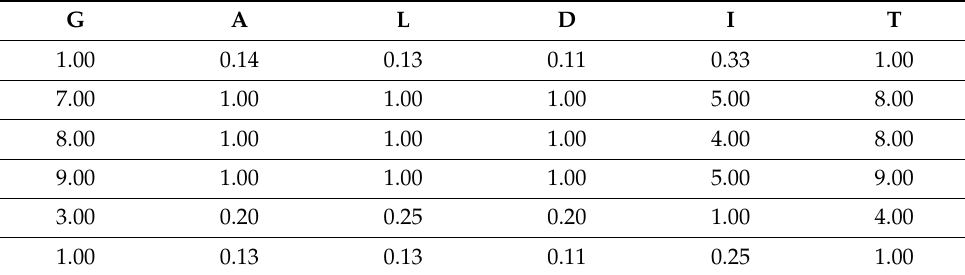
Table 4. The decision matrix of the AHP